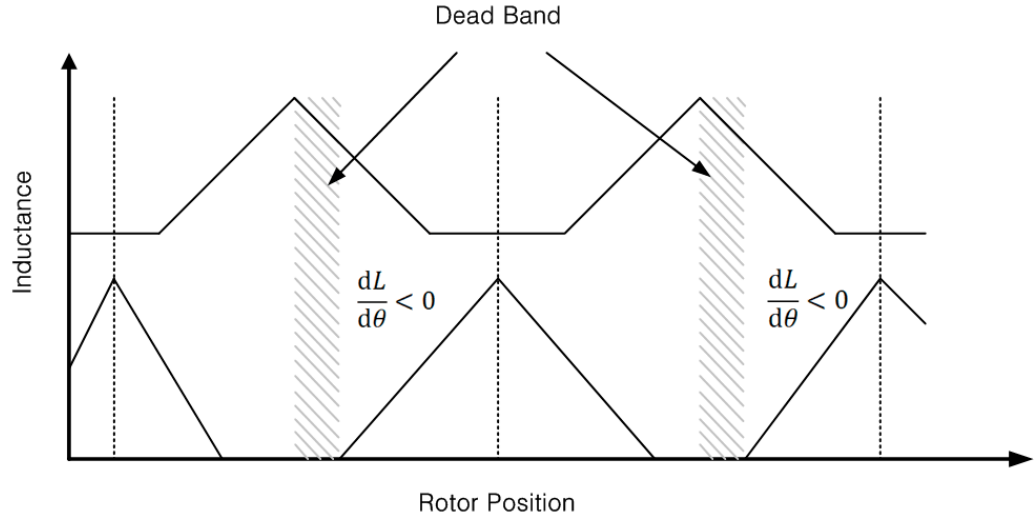
Figure 6. Uniform air gap inductance graph of the proposed two ‐ phase 4/2 pole SRM.